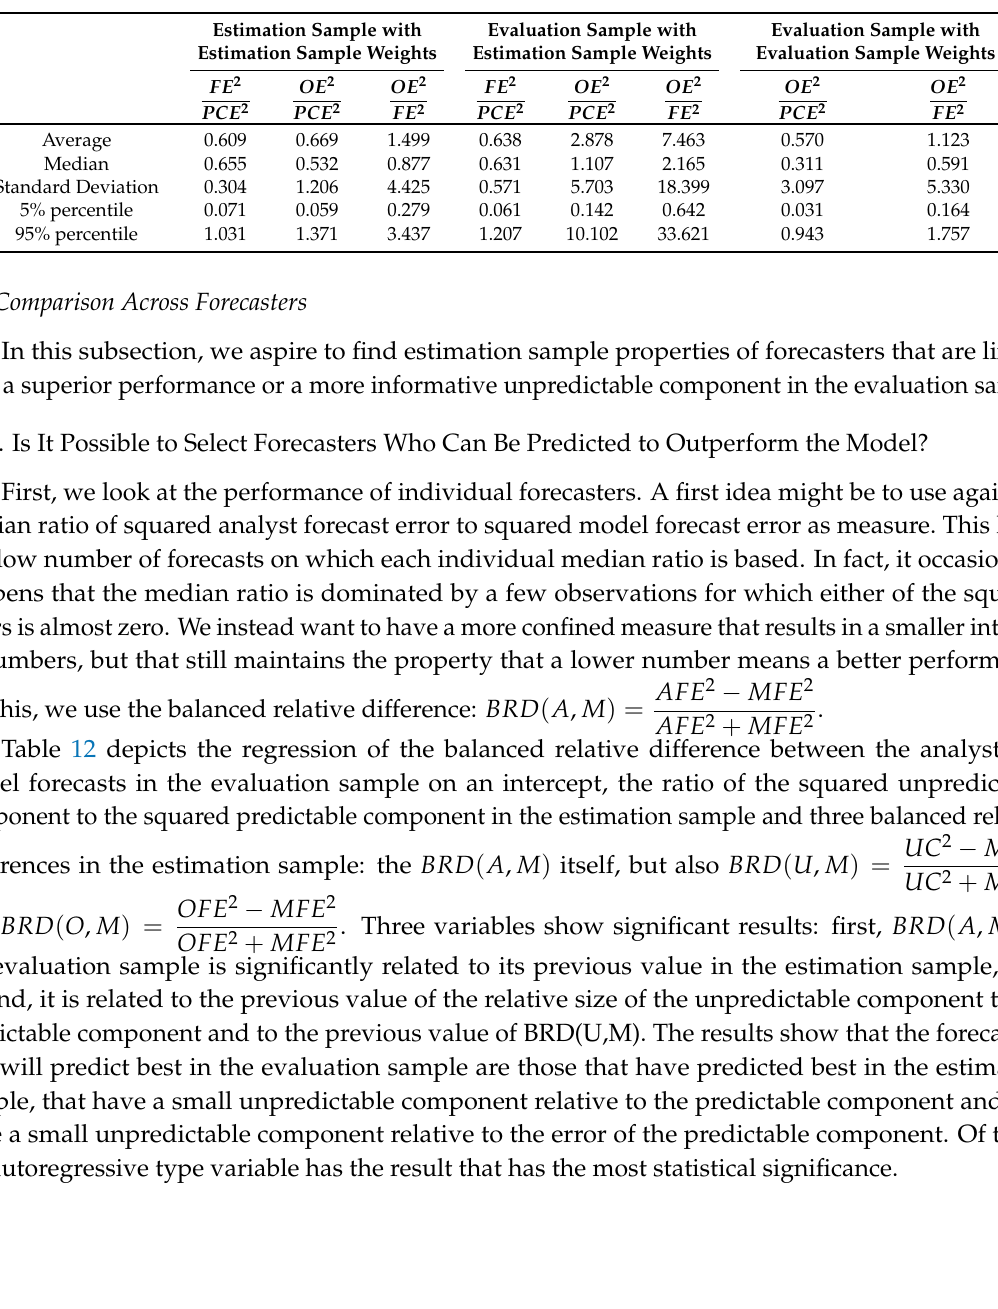
Table 11. A summary of results on the median ratios between two squared errors. Used are combinations of the following: FE 2 , the squared analyst forecast error; PCE 2 , the squared error of using the predictable component as forecast; and OE 2 , the squared error of the optimal combination of the predictable component and unpredictable component variables. We calculated these median ratios for each firm separately (of the 316 firms) but pooled the ratios of all 18,338 forecasters. The total number of observations across all firms is 146,319 in the estimation sample and 126,651 in the evaluation sample. We calculated some ratios in the evaluation sample twice: once with the weights (used in the construction of the optimal forecast) as estimated in the estimation sample, and once using weights based on the evaluation sample